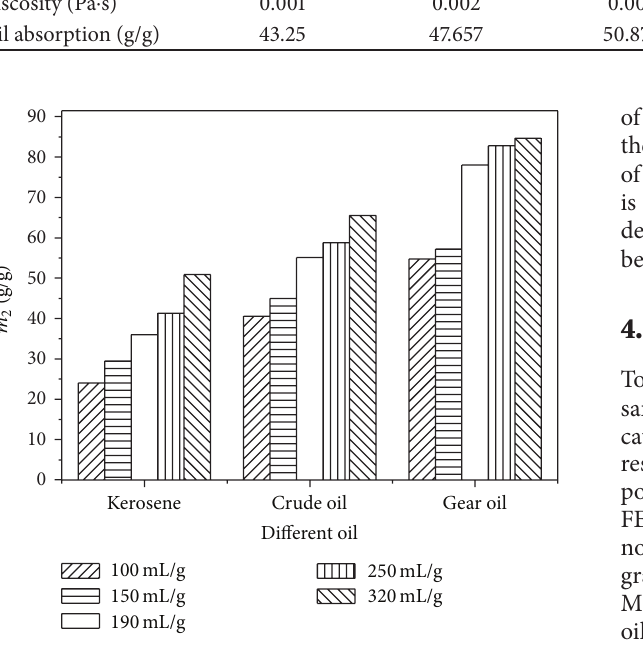
Figure 6: The effect of expanded volume on sorption capacity of the MEG